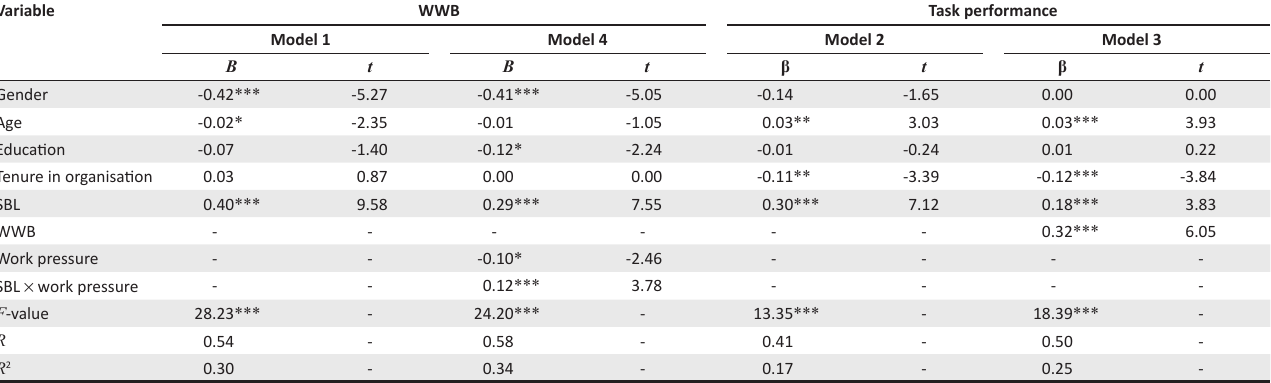
TABLE 3: Results for mediation and moderation analyses.